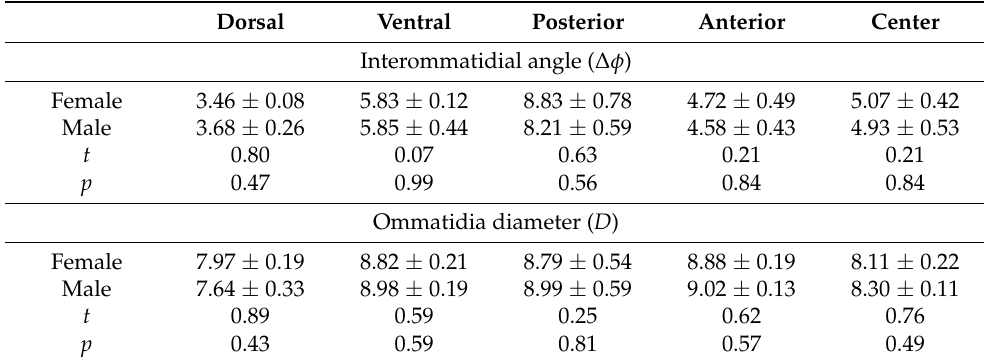
Table 1. Interommatidial angle ( ∆ φ ) and ommatidia diameter ( D ) of male and female Empoasca onukii compound eyes (mean ± SE).